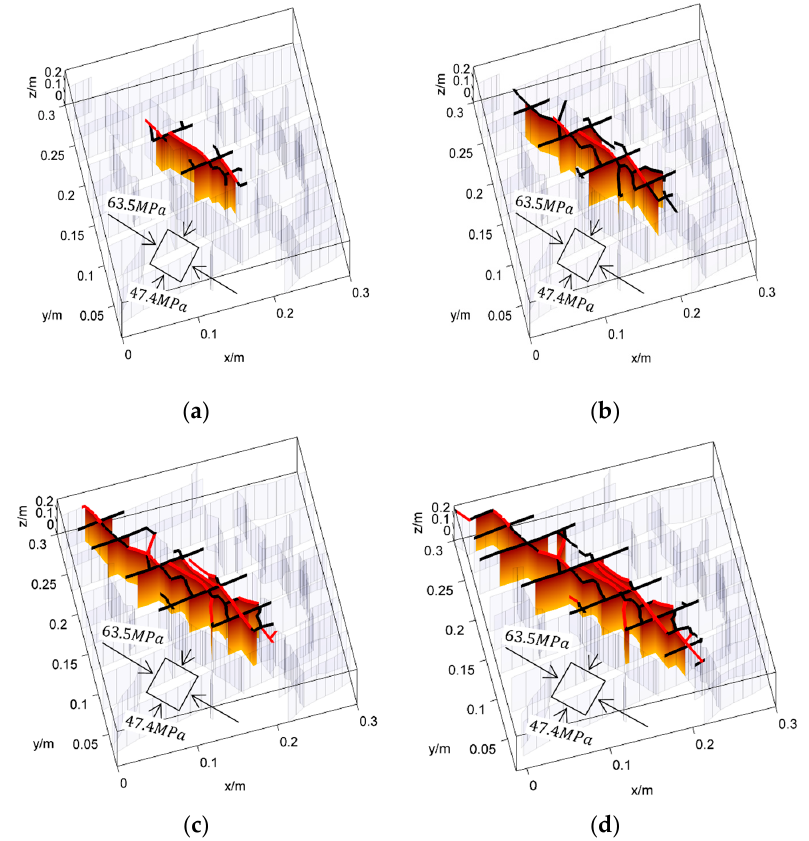
Figure 10. The propagation processes of the hydraulic fractures when the far field stress is σ max = 63.5 MPa, σ min = 47.4 MPa. The tensile mode fractures that are affected by fluid pressure are represented by the colored faces. The newly formed hydraulic fractures are marked by the bold red curves at top. The shearing fractures are marked by the bold black curves at top. The unaffected fractures are represented by the light mesh.